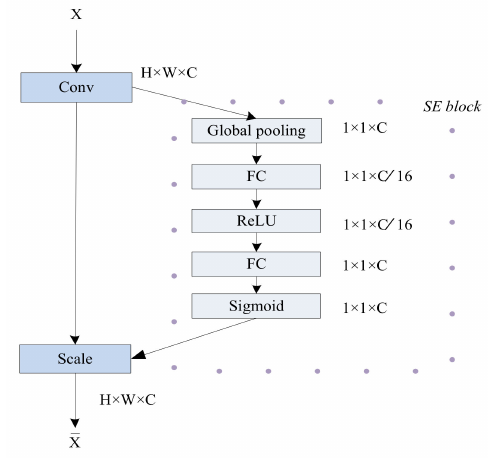
Figure 6. The structure of SE